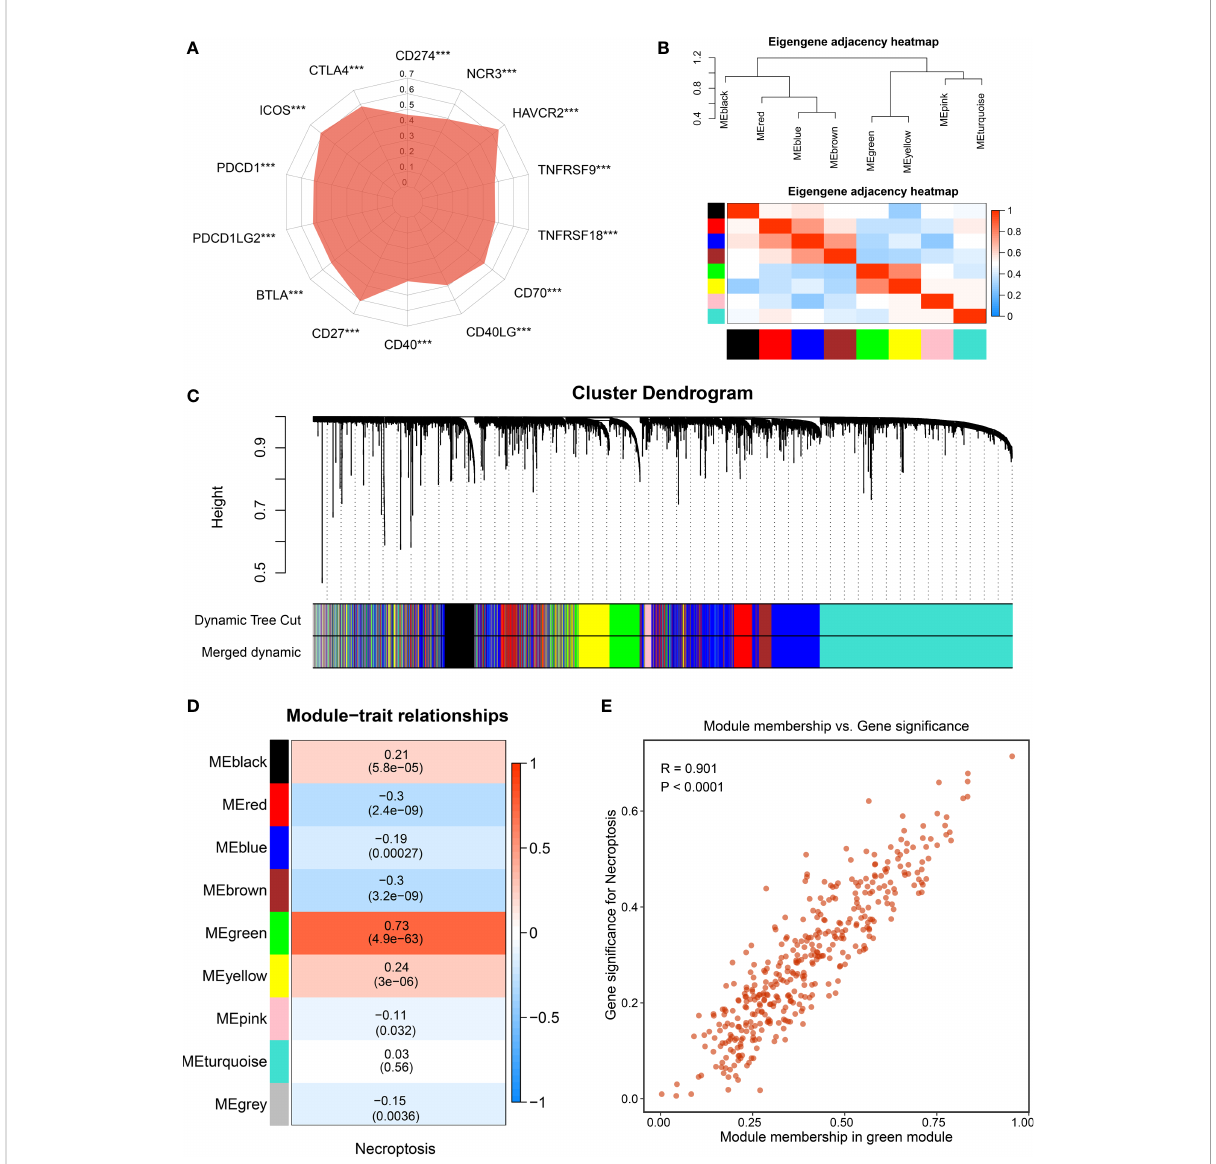
FIGURE 3 The identi fi cation of necroptosis-associated lncRNAs. (A) Correlations between the expression of immune checkpoint molecules and necroptosis score. (B) The heatmap reveals the eigengene adjacency of distinct modules. (C) Clustering dendrograms of co-expression network modules; each module was assigned a color. (D) Correlation analysis between gene modules and necroptosis score. (E) The scatterplot of module membership (MM) vs gene signi fi cance (GS) of the necroptosis score. ***p <